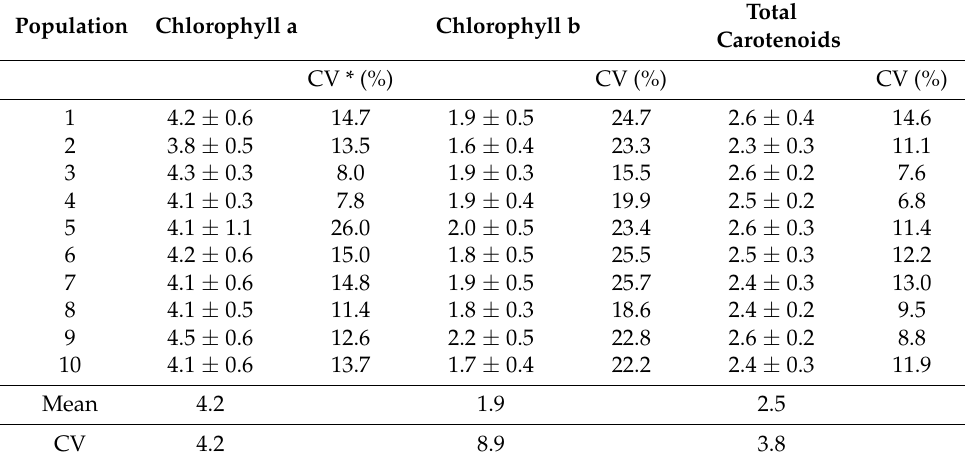
Table 3. The content of chlorophylls (mg/g) and carotenoids (mg/100 g DW).